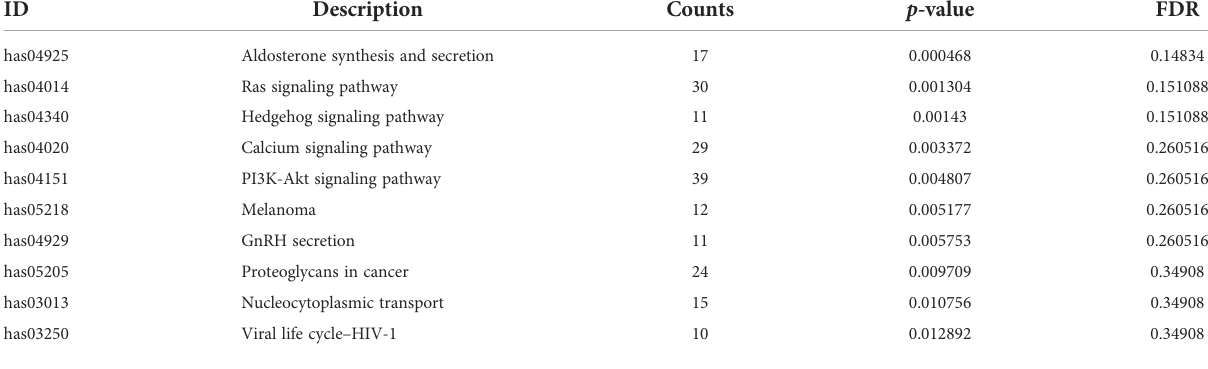
TABLE 4 Top 10 KEGG pathways in module brown ( p -value<